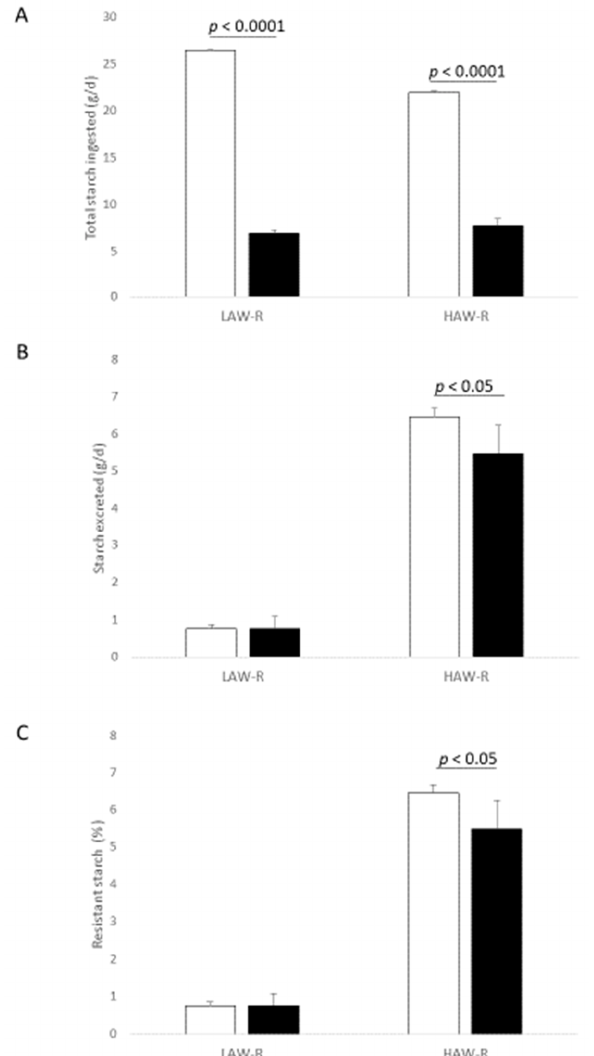
Figure 1. Comparison of ( A ) total starch ingested ( B ) starch excreted and ( C ) resistant starch content of breads made from refined flours in human ileostomates and ileorectomised rats. Values are means with standard deviation of the mean represented by vertical bars. □ Human ileostomate data n = 6, ■ ileorectomised rats data n = 3. p values were obtained by an unpaired t -tests. During the initial 11 day phase of consuming the test diets the ileorectostomised rats fed diets containing HAW-R flour had lower body weight gain compared to diets contain- ing LAW-R flour ( p < 0.05) and a trend to a lower feed conversion efficiency ratio ( p =